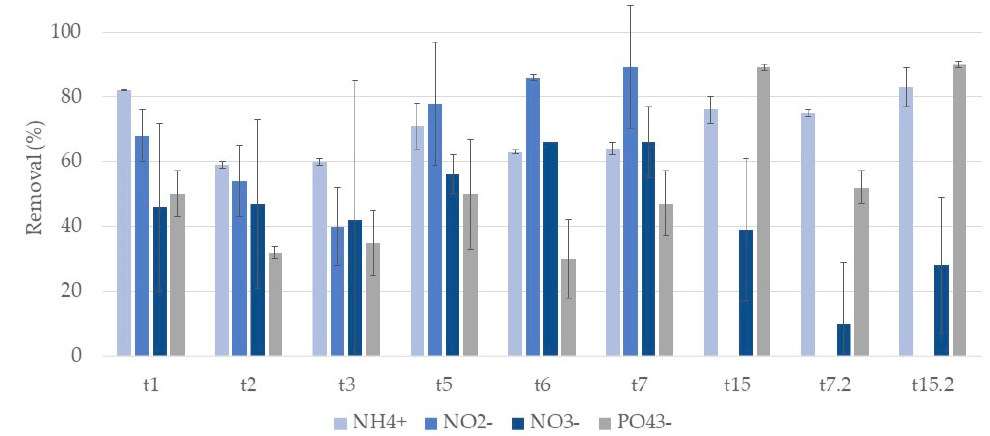
Figure 7. Removal percentage and respective standard deviation ( n = 3) for each nutrient ion, in CWs with expanded clay (A) and P. australis during the two cycles of treatment. First cycle: samples taken after one day (t1), two days (t2), three days (t3), five days (t5), six days (t6), seven days (t7), and at the end of the two-week cycle (t15). Second cycle: samples taken after one week (t7.2) and at the end of the two-week cycle (t15.2) of treatment. At t6, only one replicate was considered for nitrate ion.